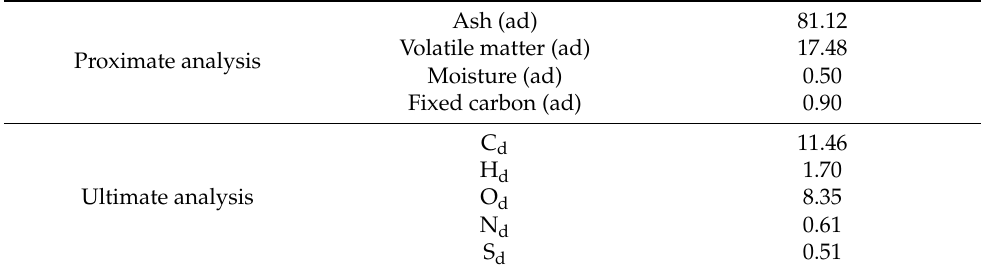
Table 1. Characteristics of Jimsar oil shale samples (wt.